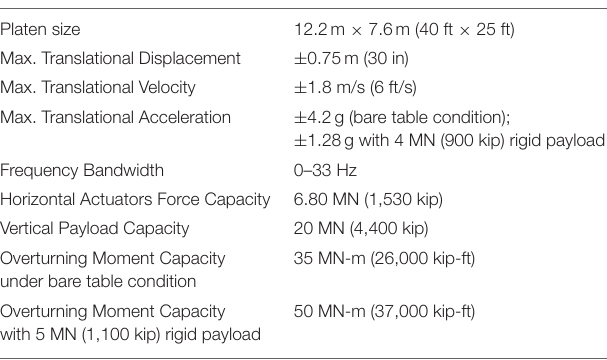
TABLE 1 | Performance characteristics of LHPOST in its 1-DOF configuration for sinusoidal motions. Platen